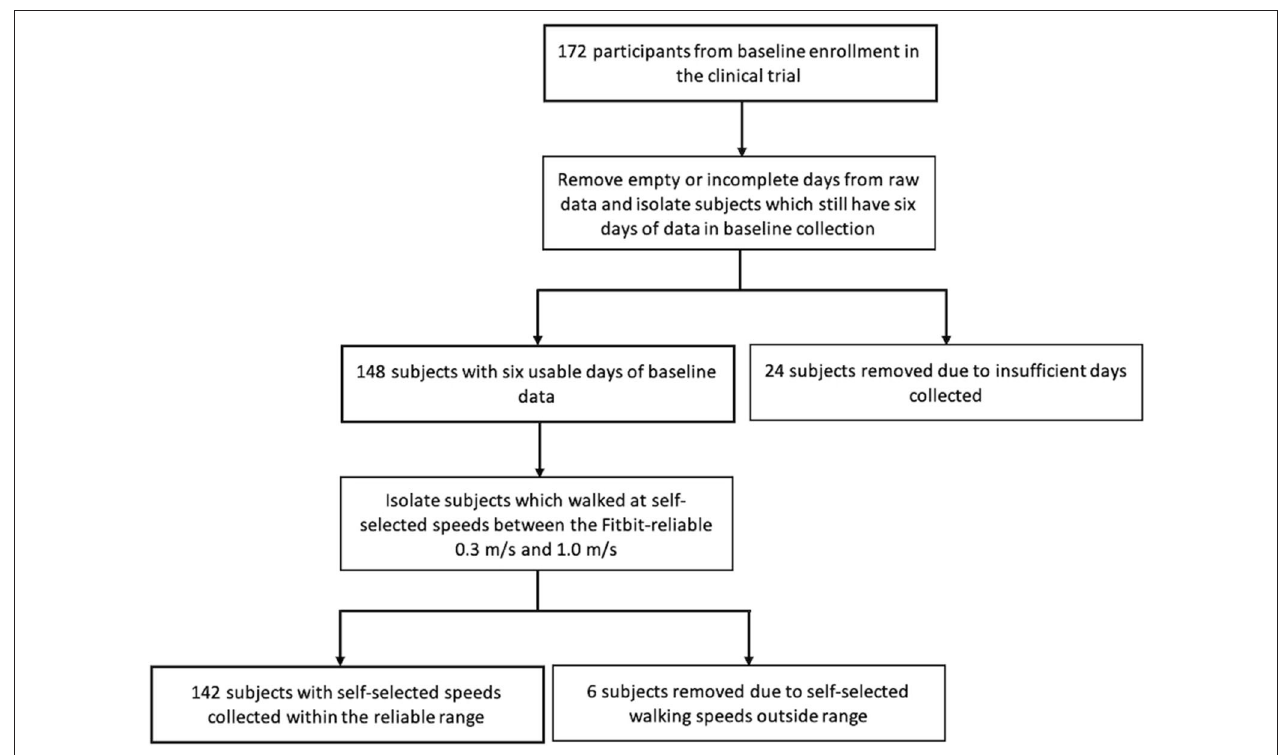
FIGURE 1 | Illustrating the decision process for including subjects in analysis.